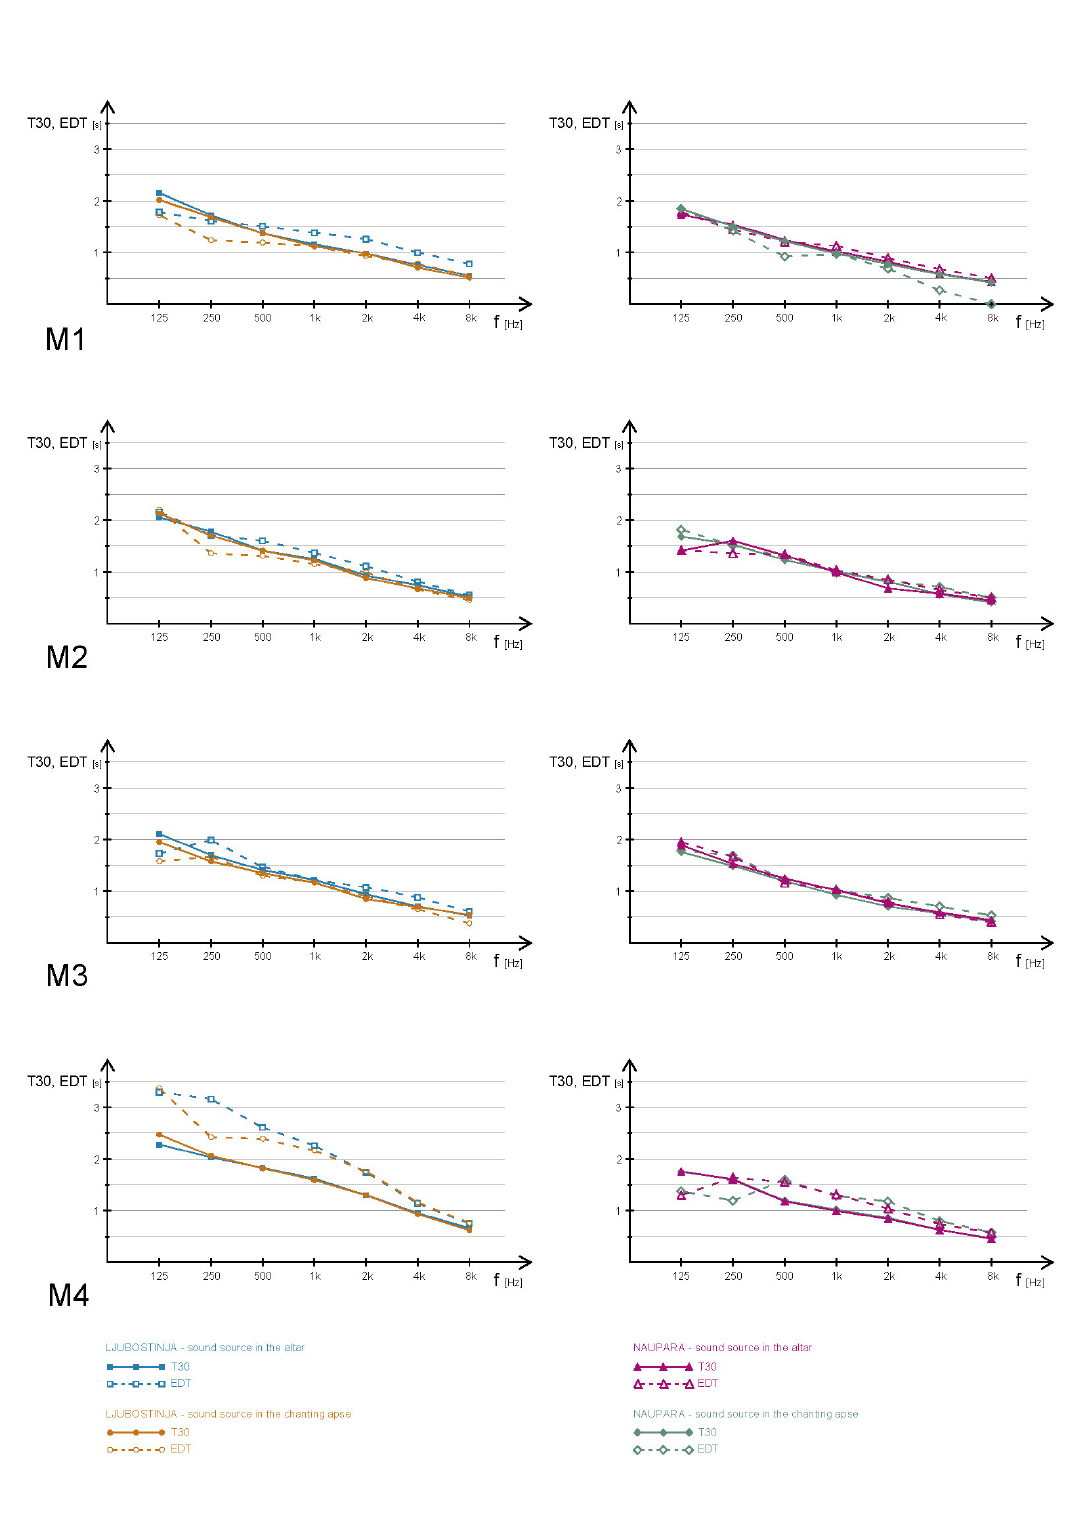
and Early Decay Time EDT in the octave range for Ljubostinja (on the left) 30